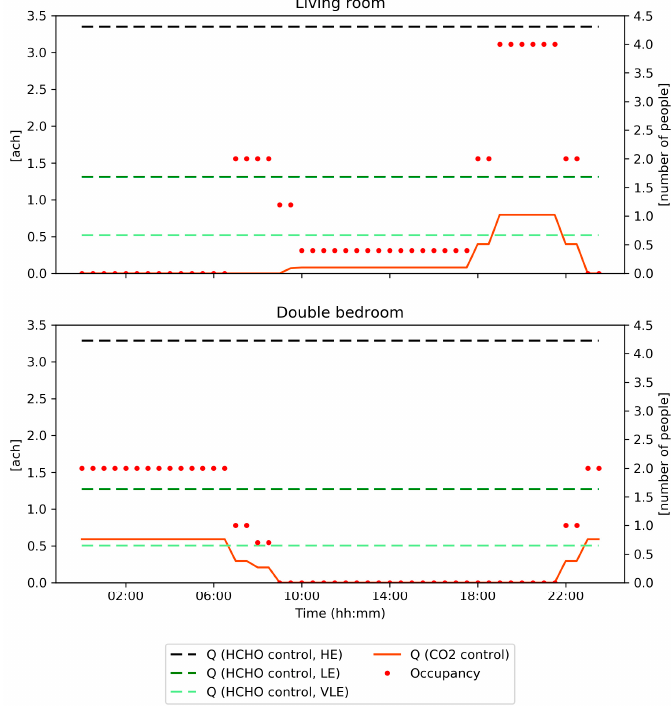
Figure 12. Required ventilation rates to maintain CO 2 and formaldehyde concentration below the guideline values for the living room and the double